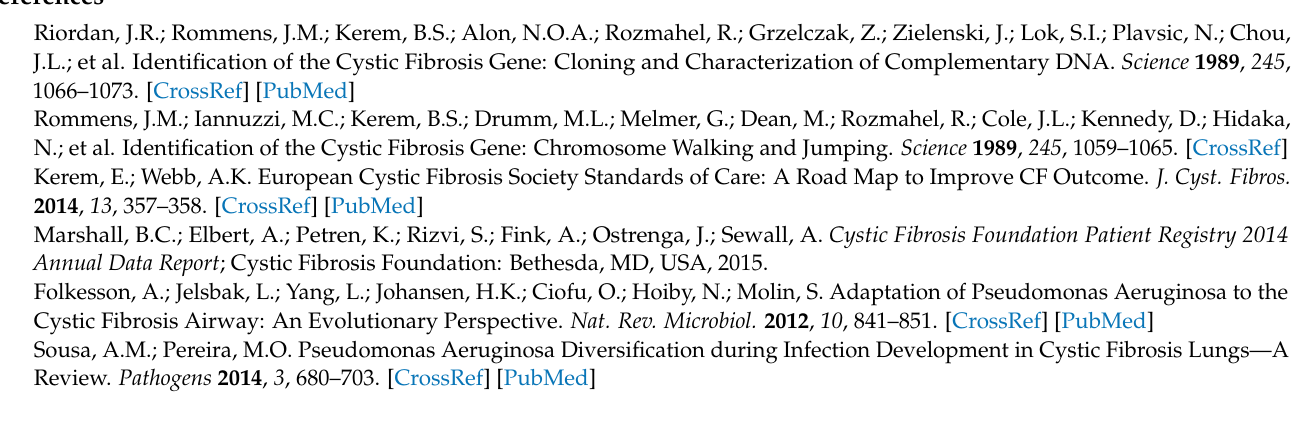
patients airways. Table S1: Global description of the study cohort. Table S2: List of 271 putatively annotated metabolites detected by untargeted LC-HRMS. Table S3: Summary of MS2 identification of 50 metabolites. Table S4: Phenotypic assay results of 66 clinical P.a isolates of the FCB. Table S5: Clinical indicators of respiratory function for the 32 CF patients of the cohort (colorblind accessible summary of Figure